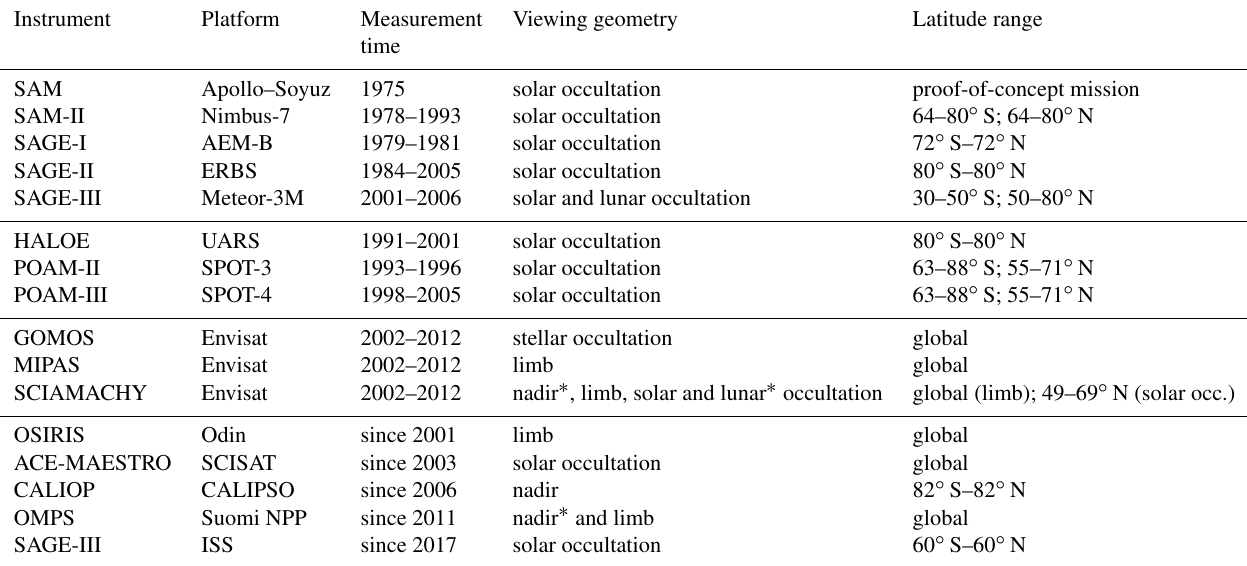
Table 1. Satellite measurements of stratospheric